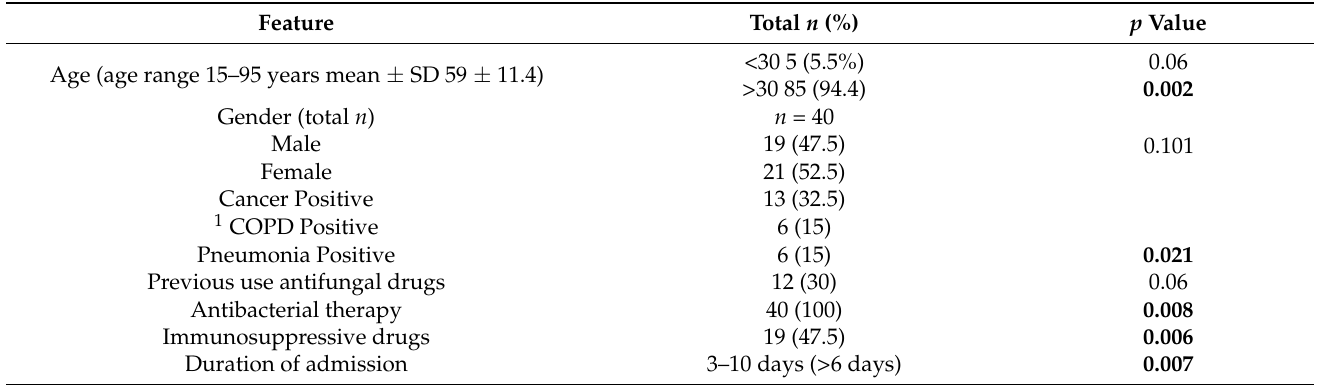
Table 2. Clinical features of the patients that participated in the ICU multi-center